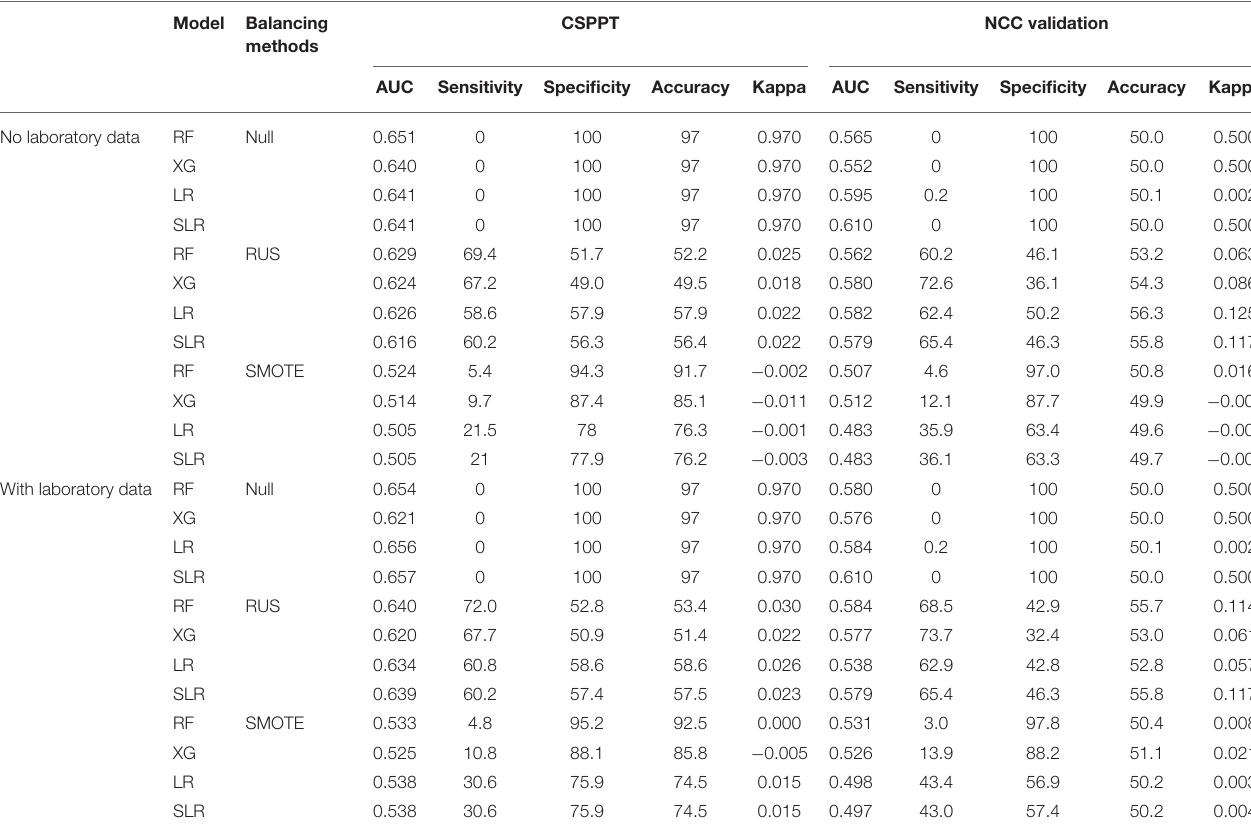
TABLE 2 | Performance of machine learning methods in different datasets with different data balancing methods.